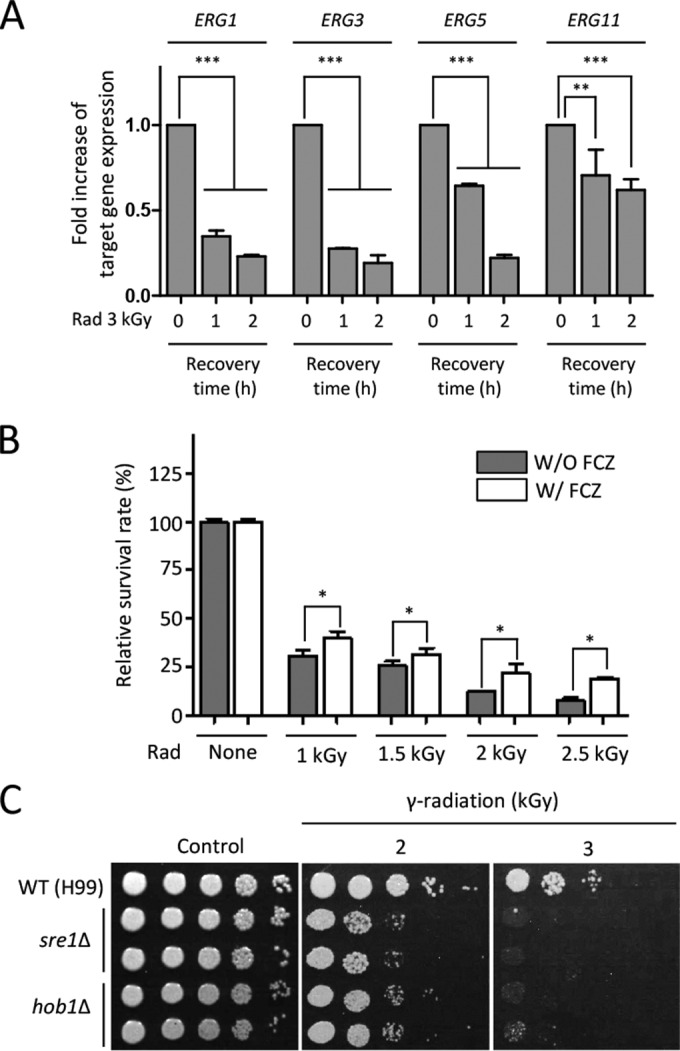
Homeostasis of ergosterol biosynthesis is required for the gamma radiation resistance of C. neoformans. (A) Expression analysis of ERG genes at the recovered time after exposure to radiation. The fold increase of ERG gene expression was quantitatively monitored using qRT analysis with the gene-specific primers listed in Table S2. Duplicate technical experiments with two biological samples were performed. Representative images from independent experiments for each ERG gene are shown. Error bars indicate standard deviations. Asterisks represent statistical significance of differences in expression levels of each ERG gene (**, P < 0.01; ***, P < 0.001). (B) Reduced ergosterol increased in the gamma radiation resistance in C. neoformans. C. neoformans WT (H99) strains were grown in a liquid medium at 30°C for 16 h, and then the grown cells were subcultured for 5 h to an OD600 of 1.0. Cells were treated with or without fluconazole (10 µg/ml) for 90 min. Next, cells treated with or without fluconazole were exposed to the indicated dose of gamma radiation for 1 h. After radiation, cells were spread onto the solid YPD medium and further incubated at 30°C for 2 days. The relative survival rate was measured as the viable cell count number at the indicated dose of radiation divided by the viable cell count number before radiation. The relative survival rates were statistically compared between cells treated with or without fluconazole using the Bonferroni selected comparison test performed with Prism software, version 5.0 (GraphPad Software, Inc.). Asterisks represent statistical significance of differences in the relative survival rate (*, P < 0.05). (C) Ergosterol homeostasis is required for gamma radiation resistance. C. neoformans WT (H99), sre1Δ (YSB2493 and YSB2494), and hob1Δ (YSB2308 and YSB2309) mutants grown overnight were 10-fold serially diluted (1 to 104) and then spotted onto the YPD medium. Cells were exposed to the indicate dose of gamma radiation for 1 h and then further incubated at 30°C for 3 days.